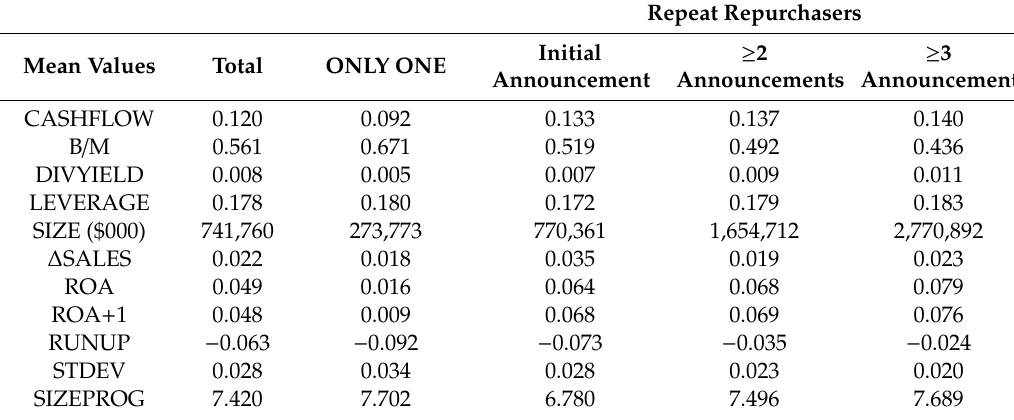
Table 5. Descriptive